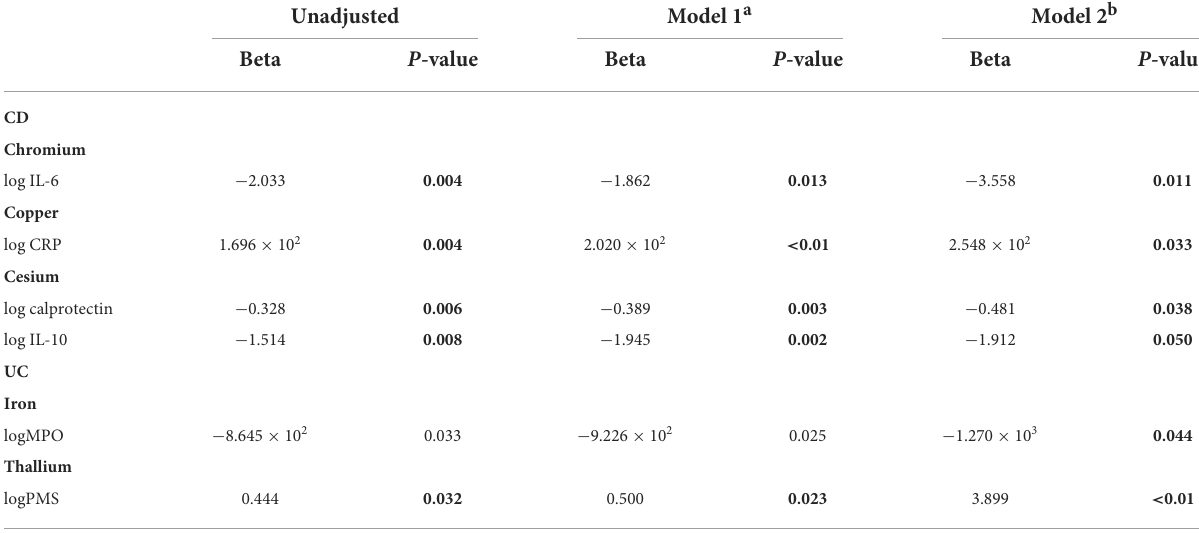
TABLE 3 Regression analysis addressing the associations between trace metals and other data where there were significant correlations (only relationships with significant results in Model 2 are